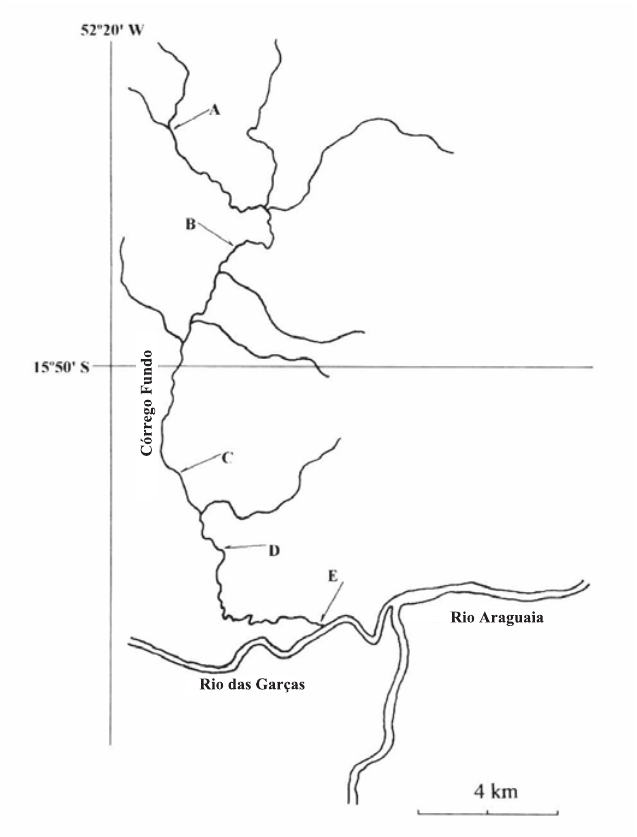
Fig. 1 . Location of the Córrego Fundo stream and the five sampling stations, identified by